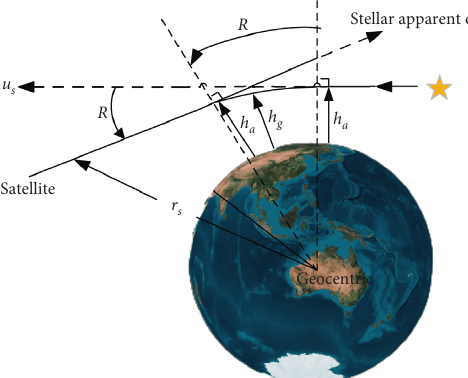
Figure 1: Principle diagram of atmospheric refraction of